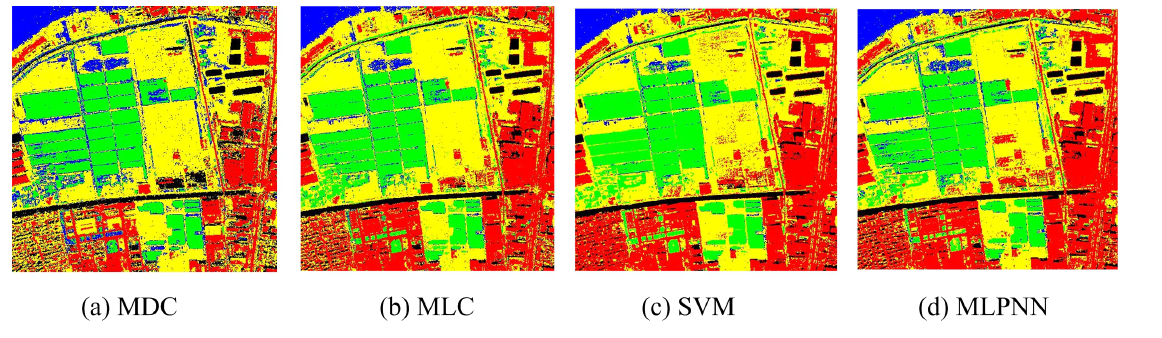
Figure 5. Classification results of using only spectral